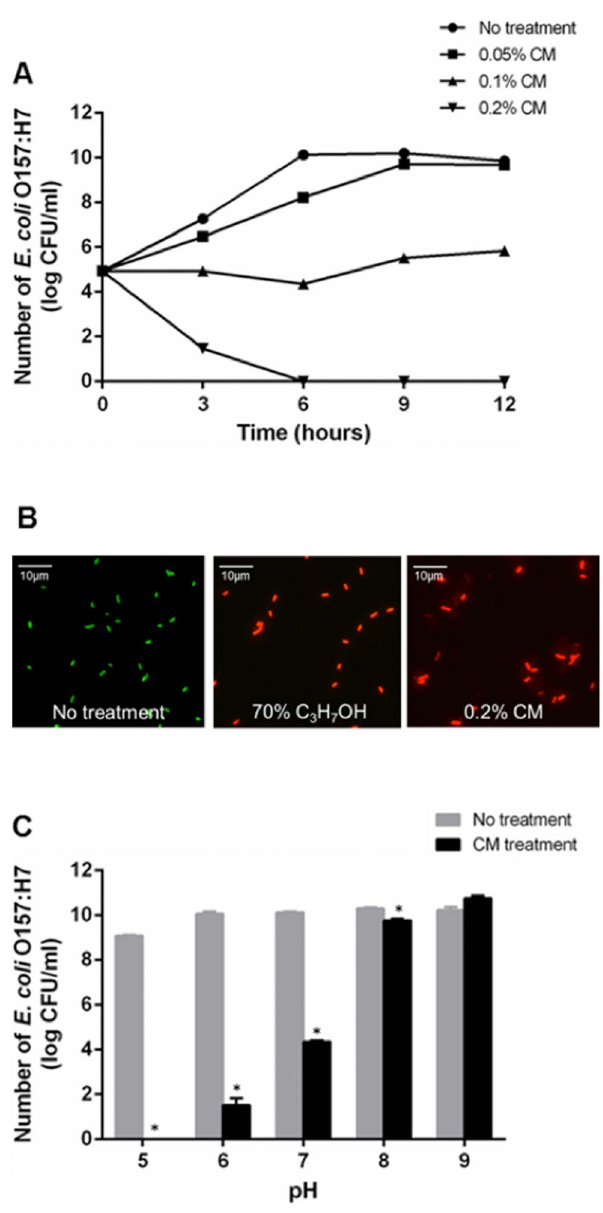
Figure 1. Antimicrobial activity of chitosan microparticles. (A) Survival curve of E. coli O157:H7 during CM treatment. E. coli O157:H7 was grown with CM at 0% (circle), 0.05% (square), 0.1% (triangle), or 0.2% (inverted triangle), and each time point represents the mean values and standard error of means (SEM) of colony forming units (CFU) recovered from triplicate test tubes. (B) LIVE/DEAD viability assay. E. coli O157:H7 was incubated with 0.2% CM at 37 u C for 3 h and then incubated with SYTO 9 (green, live) and propidium iodide (red, dead) for 15 minutes, and then bacteria were observed using the fluorescence microscope (Leica Microsystems Wetzlar GmbH, Germany). Fluorescent micrograph of E. coli O157:H7 treated with either 0% CM (left), 70% isopropanol (middle), or 0.2% CM. Results shown are representative of three independent experiments. (C) pH effect on antimicrobial activity of CM. E. coli O157:H7 was incubated for 6 h in the presence of 0.1% CM in LB broth at various pH (ranging from pH 5 to pH 9) and viable cells were counted using direct plating method; Mean values 6 SEM are plotted from three independent experiments; * P , 0.05, t -test.